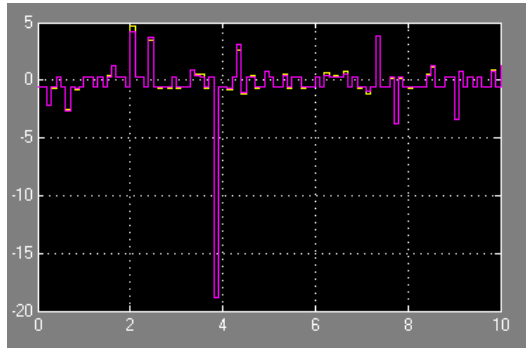
Figure 18. model with using ANN of Scope 3 ‘G 4